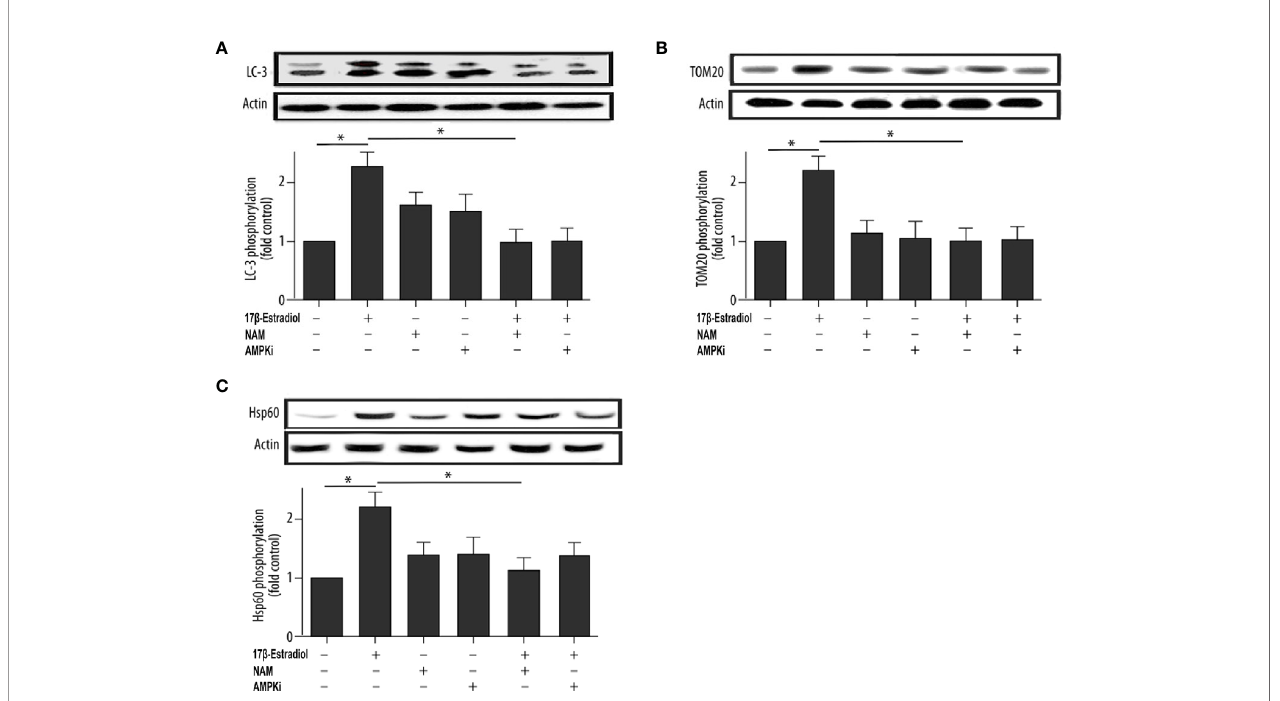
FIGURE 2 | 17 b -E2 treatment upregulated the phosphorylation level of LC3, TOM20, and Hsp60 in ATDC5 chondrocytes. The chondrocytes were pretreated with 15 m M NAM or 20 m M Compound C for 30 min and then incubated with or without 1 × 10 -7 M 17 b -E2 for 24 h. The phosphorylation levels of (A) microtubule- associated protein 1A/1B light chain 3 (LC3), (B) translocase of outer membrane 20 (TOM20), (C) heat shock protein 60 (Hsp60), and b -actin protein were detected by Western blot analysis. These experiments were independently repeated 3 times. * P < 0.05 versus the control group indicated a signi fi cant